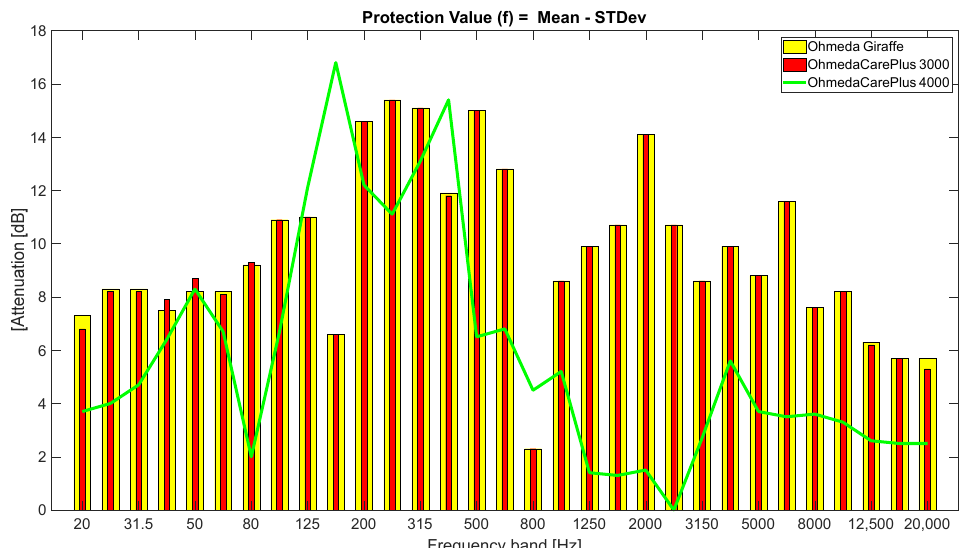
Figure 5. Frequency-dependent attenuation level for the worst situation (Mean – StdDev).